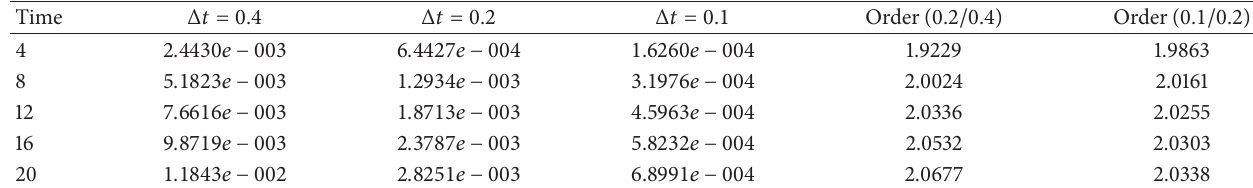
Table 4: Convergence order and error in 𝐿 2 norm for 𝑞 of time with ℎ = 0.125 and 𝑐 = 0.1